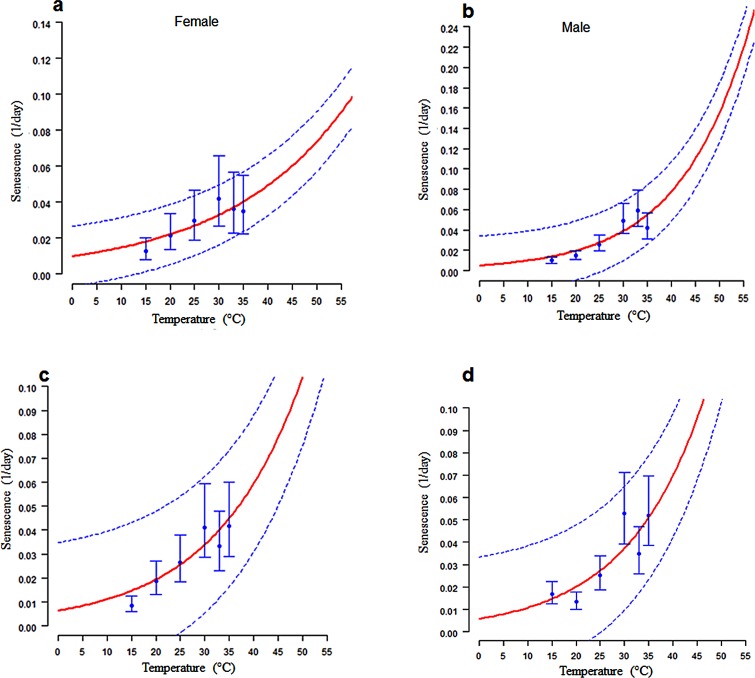
Temperature-dependent senescence rates (1/days) for adult C. rosa females (4a) and C. rosa males (4b); and for C. quilicii females (4c) and C. quilicii males (4d). Fitted curves: Exponential model for both sexes for each fruit fly species. The upper and lower 95% confidence intervals of the models are indicated. Bar represent standard deviation of the mean.